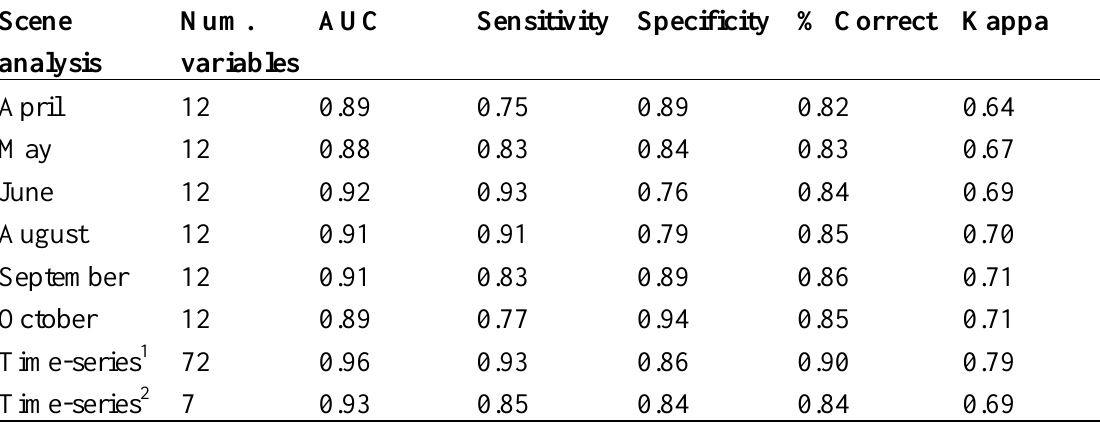
Table 1. Tamarisk model evaluations of single-scene and time-series analyses of Landsat 7 scenes and associated vegetation indices generated using the ROC/AUC